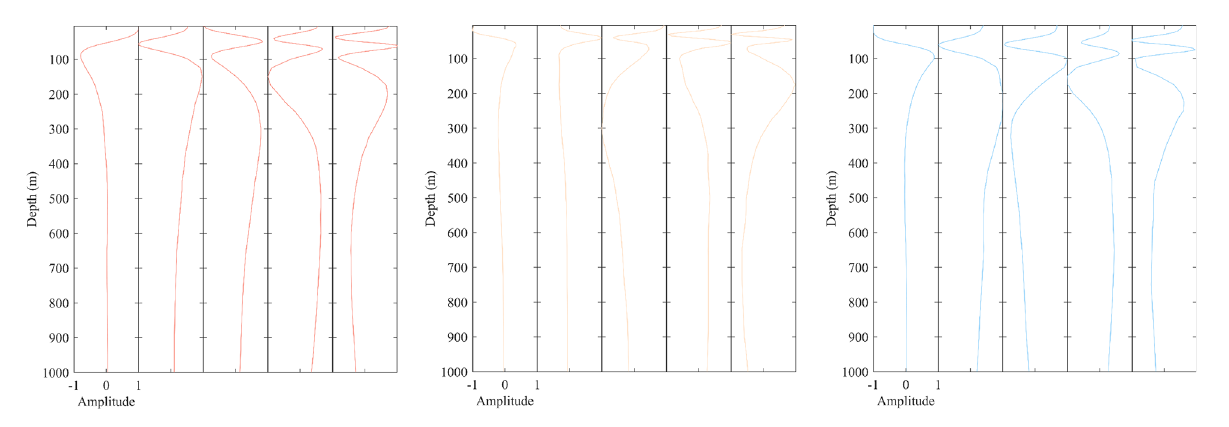
FIGURE 8 The fi rst fi ve orders of modalities of Type 1~Type3.